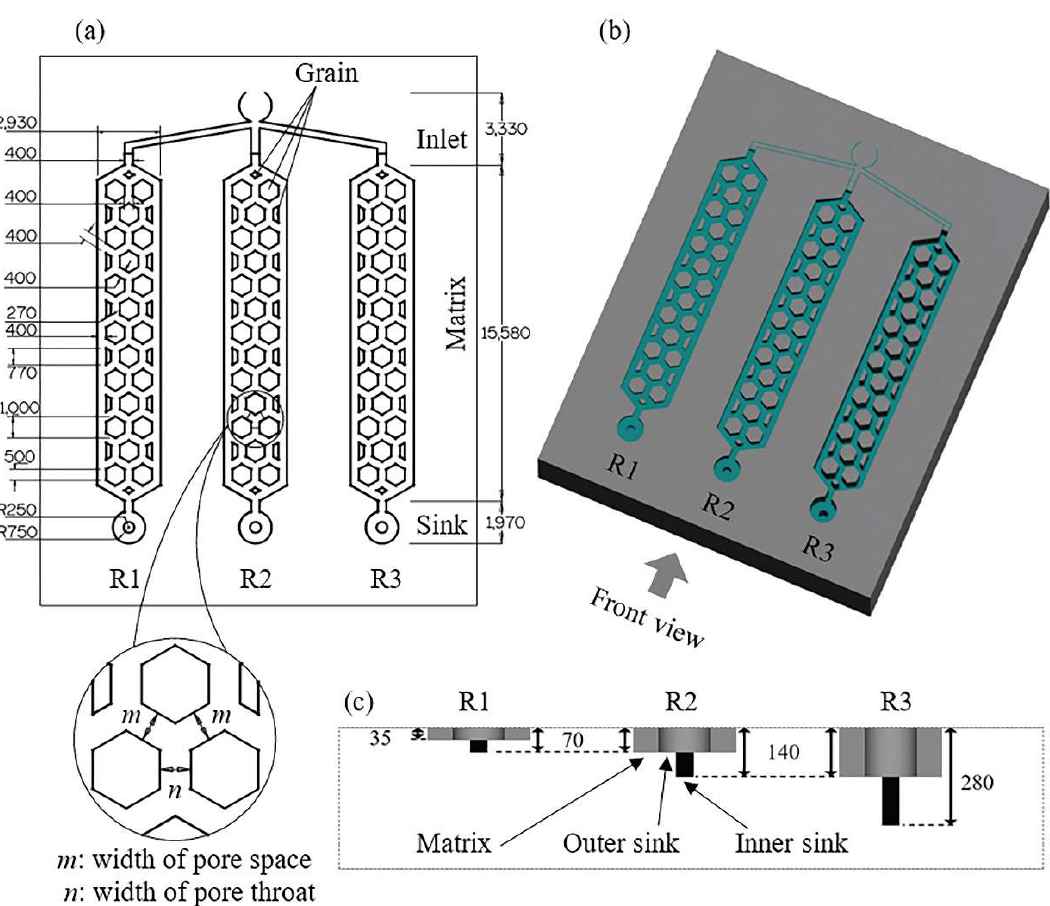
Figure 6. CAD schematic illustration of the 3D multi-depth reservoir (R) micromodel. ( a ) a 2D top view showing a description of all components of the micromodel and their dimensions in µm units, and a zoom-in portion that shows the pore body bounded by 3 solid hexagon grains, and the uniform widths of the pore space (m) and pore throat (n) which gives an aspect ratio ( 𝑚 𝑛⁄ ) = 1. ( b ) a 3D top view design showing the borosilicate glass substrate (grey) and the etch area (green) with multiple depths. ( c ) a front view of (b), grey arrow direction, showing the 4 depths of the reservoir micromodel –35, 70, 140, and 280 µm relative to the surface of the borosilicate substrate. The notations used here are R1 matrix, R1 outer sink, and R1 inner sink that represents the main reservoir matrix, the large outer circular sink, and the small inner circular sink of reservoir 1, etc. Emphasis was placed on the reservoir matrices and sinks, therefore portions (grey area) of the inlet channel was not etched as shown in (b).